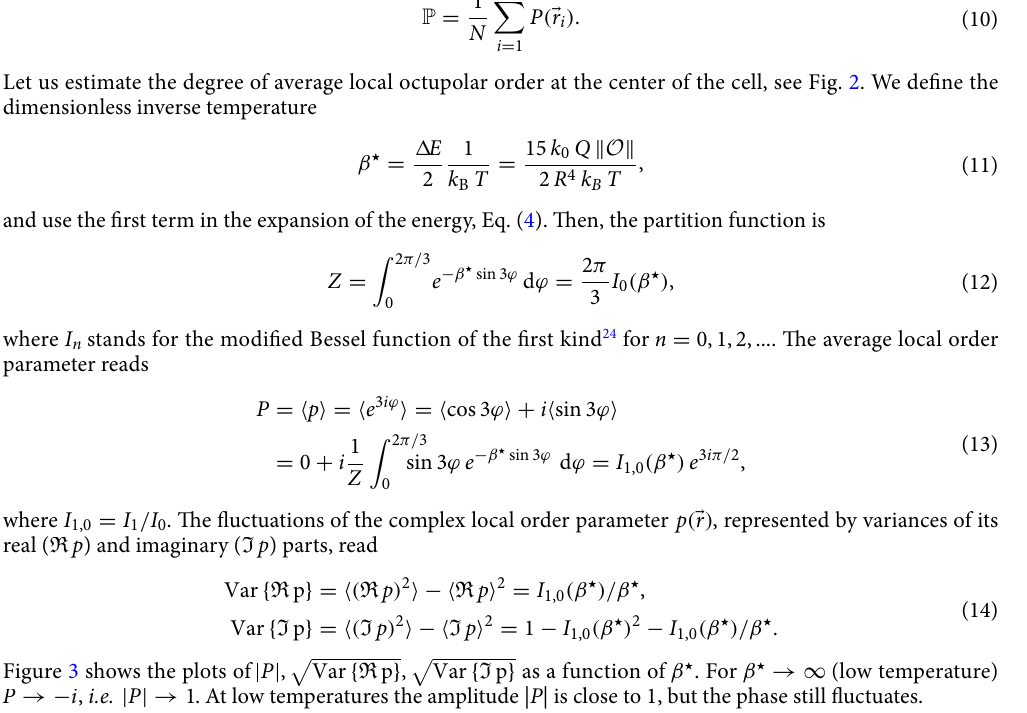
I p Var (blue dotted { } (cid:31)